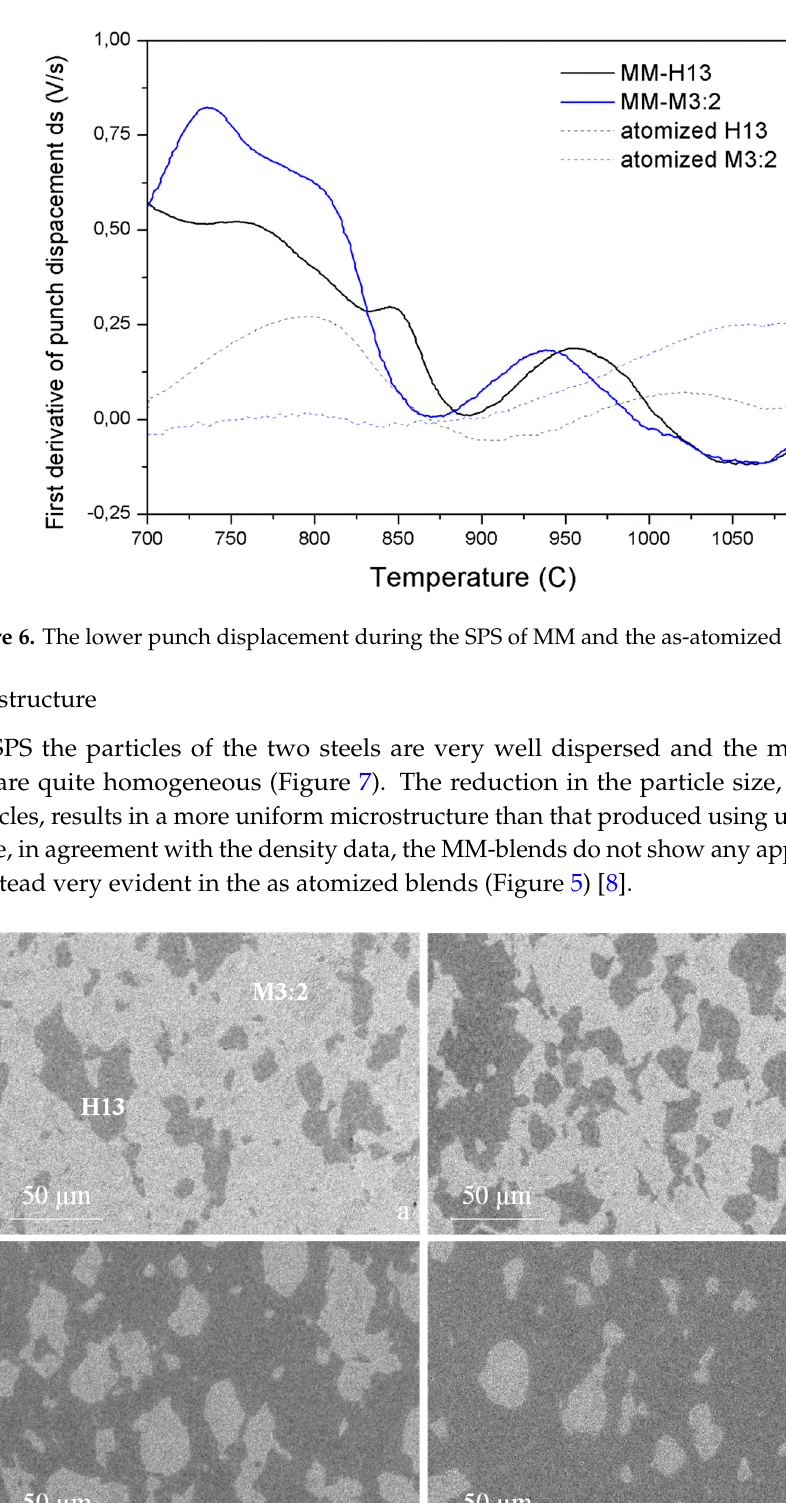
6 of 13 Figure 5. Density and relative density of the sintered specimens as a function of AISI H13 content. In the case of specimens fabricated using as-atomized powders, the relative density of all blends was less than the density of the two base steels, and all of these blends did not achieve the theoretical density predicted by the linear rule of mixtures. These specimens presented a large amount of porosity, which could be attributed to the different sintering kinetics of the two steels [8]. The sintering process of the as-atomized AISI H13 began at a lower temperature than in AISI M3:2, so the subsequent densification of the HSS was hindered by the presence of a rigid AISI H13 skeleton [8].